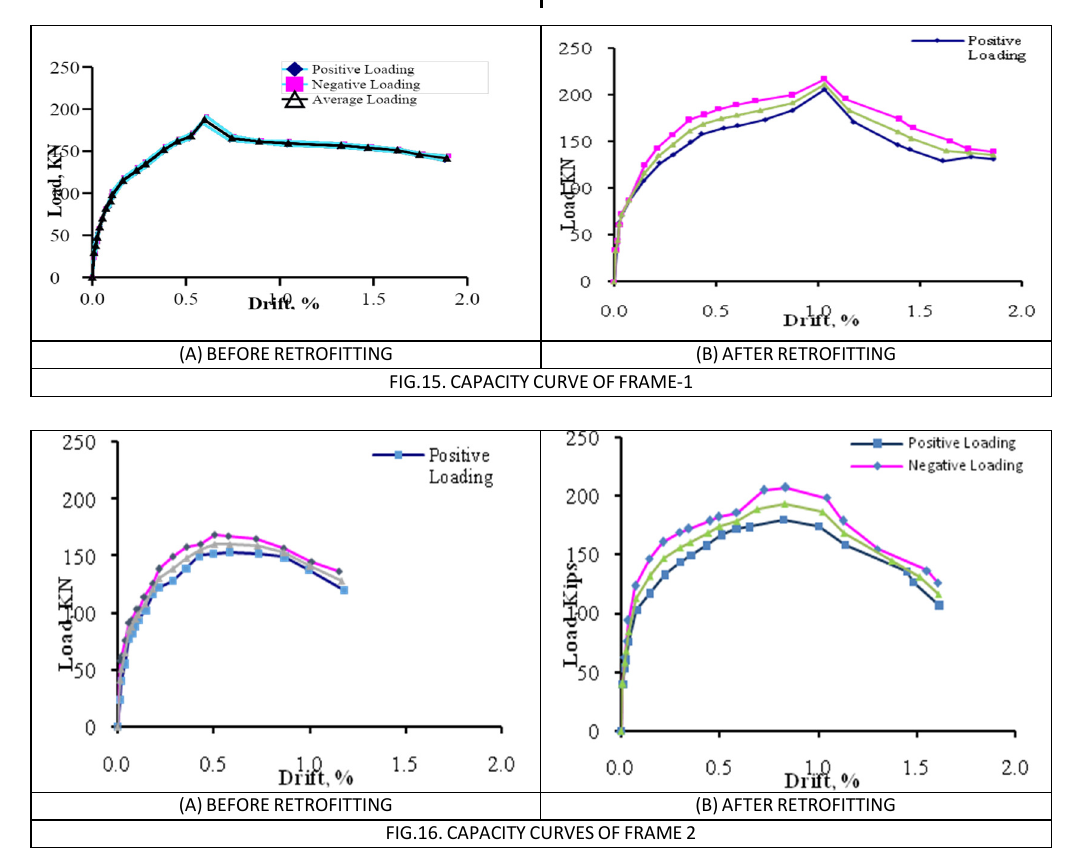
FIG.16. CAPACITY CURVES OF FRAME